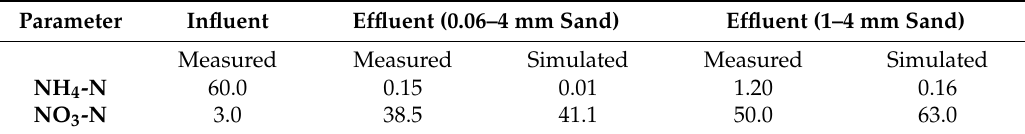
Table 4. Median values of measured and simulated influent and effluent concentrations for NH 4 ‐ N and NO 3 ‐ N in mg/L (adapted from [16]).